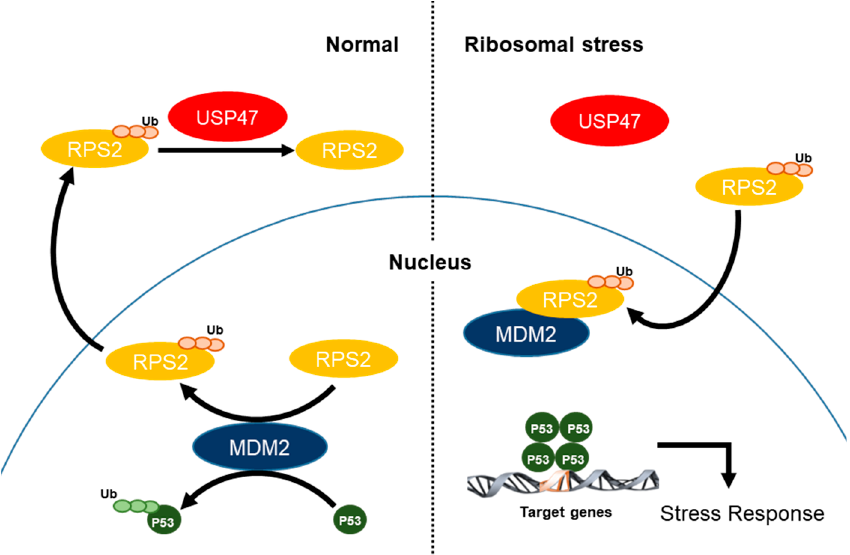
Figure 8. A schematic overview. Under normal conditions, USP47 deubiquitinates RPS2, and thus MDM2 inhibits p53 to maintain p53 protein levels. Under ribosomal stress, USP47 dissociates from RPS2, and thus ubiquitination of RPS2 is accumulated thereby inhibiting MDM2 to induce p53 protein levels for turning on the stress response